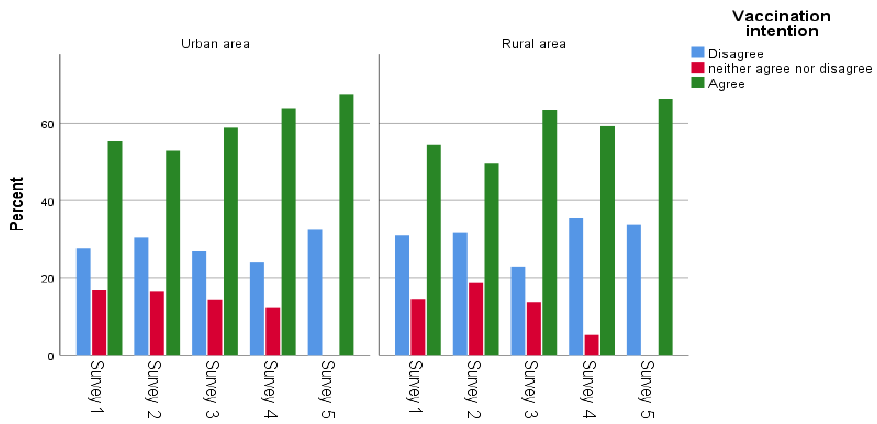
Figure 5. Years of education and vaccination intention across the surveys.